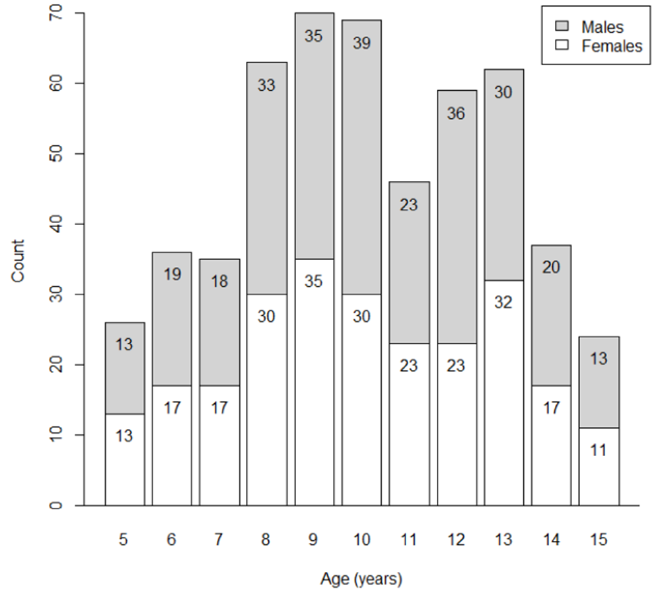
Figure 1. Frequency distribution of the sample by sex and age cohort.